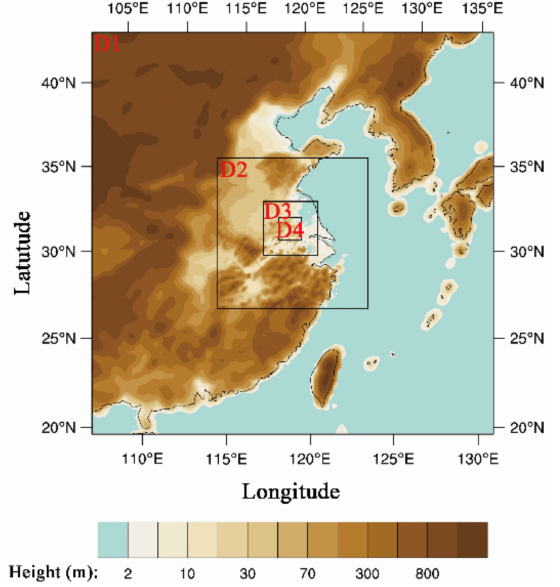
Figure 2. Simulated domain of WRF model: scope of the four nested domains (D1–D4) used in the meteorological simulation.